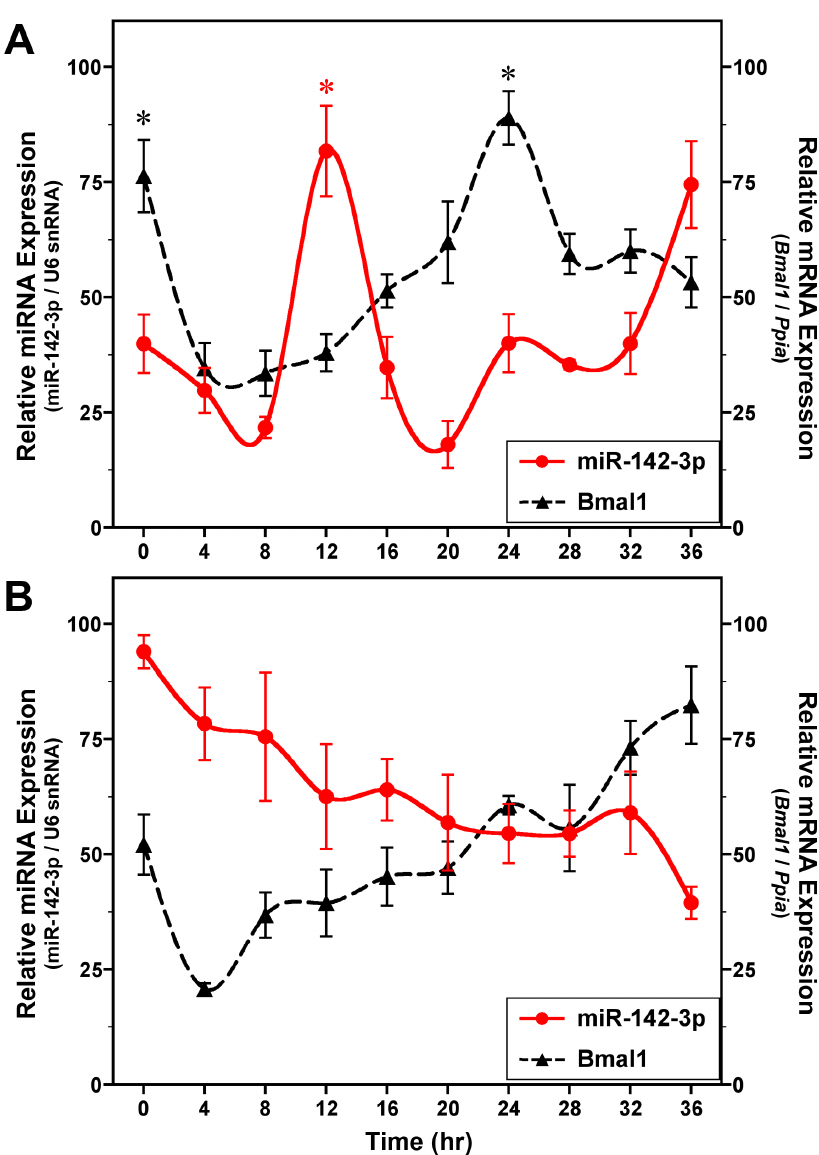
Figure 2. Temporal patterns of miR-142-3p and Bmal1 expression in immortalized SCN cells invitro . Symbols denote real-time PCR determinations (mean 6 SEM) of miR-142-3p (red) and Bmal1 mRNA (black) levels at 4-hour intervals in cultures (n=4–5) of mPer2 Luc SCN cells ( A ) and immortalized SCN cells ( Per1 ldc /Per2 ldc ) with targeted disruption of Per1 and Per2 ( B ). The plotted values correspond to the ratios of miR-142-3p signal normalized to U6 snRNA levels and of Bmal1 / Ppia mRNA signal in which the maximal value for each gene was set at 100%. Asterisks indicate time points during which peak levels were significantly greater ( p , 0.05) than those observed during preceding or succeeding minima.